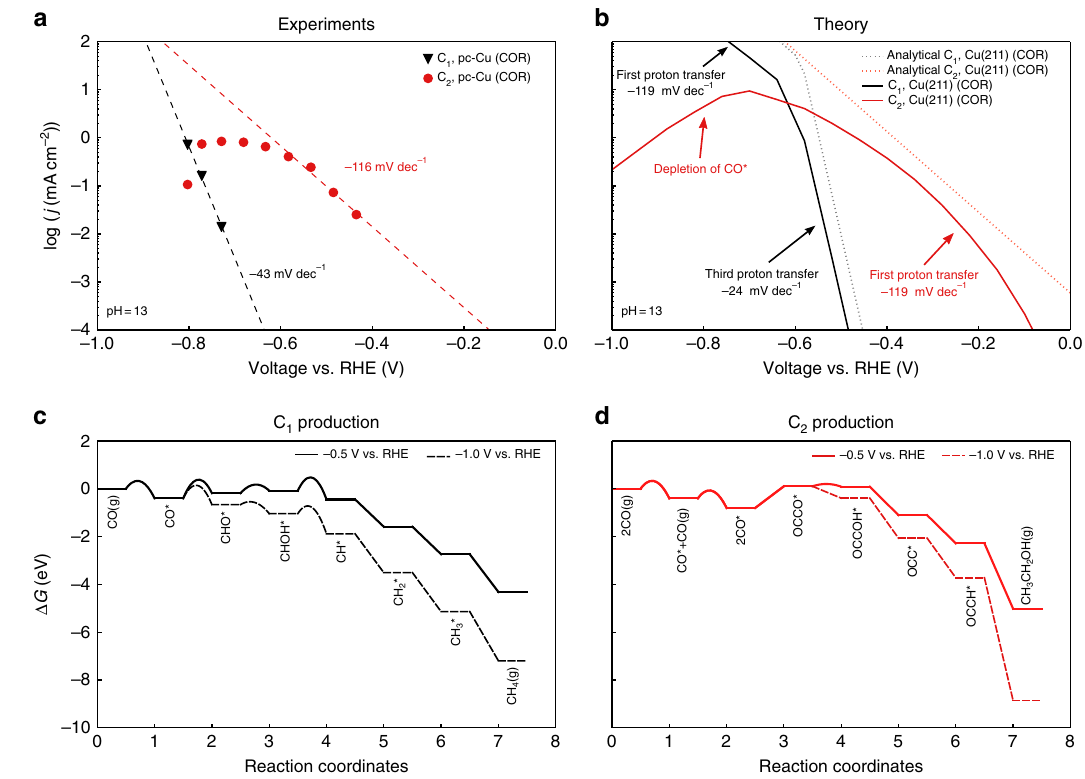
Fig. 2 Polarization curves and free energy diagrams for C 1 and C 2 products on Cu. a Experimental polarization curves on pc-Cu of CO reduction toward C 1 and C 2 products at pH = 13. Data are taken from ref. 26 . b Predicted polarization curves from the full microkinetic model and the associated analytical approximation on Cu(211) of CO reduction toward C 1 and C 2 products at pH = 13. c Free energy diagram for a dominant pathway at low coverage for C 1 formation at – 0.5 V and – 1.0 V vs. RHE. d Free energy diagram for the dominant pathway at low coverage for C 2 formation at – 0.5 V and – 1.0 V vs.